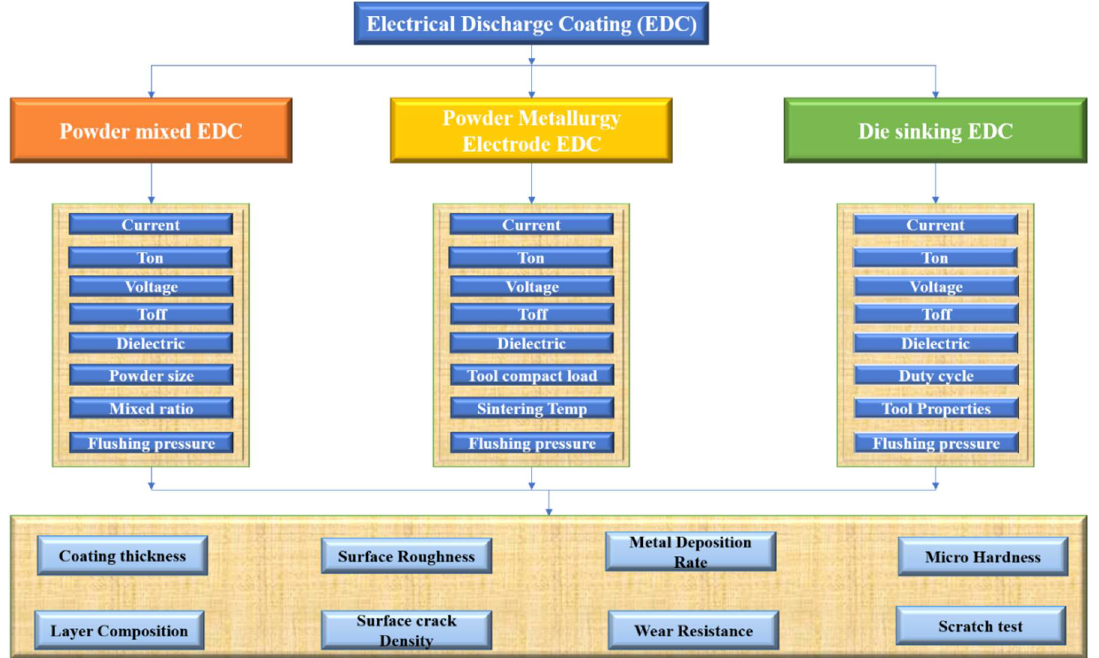
Figure 4. Flowchart for different types of EDC process input and output parameters.